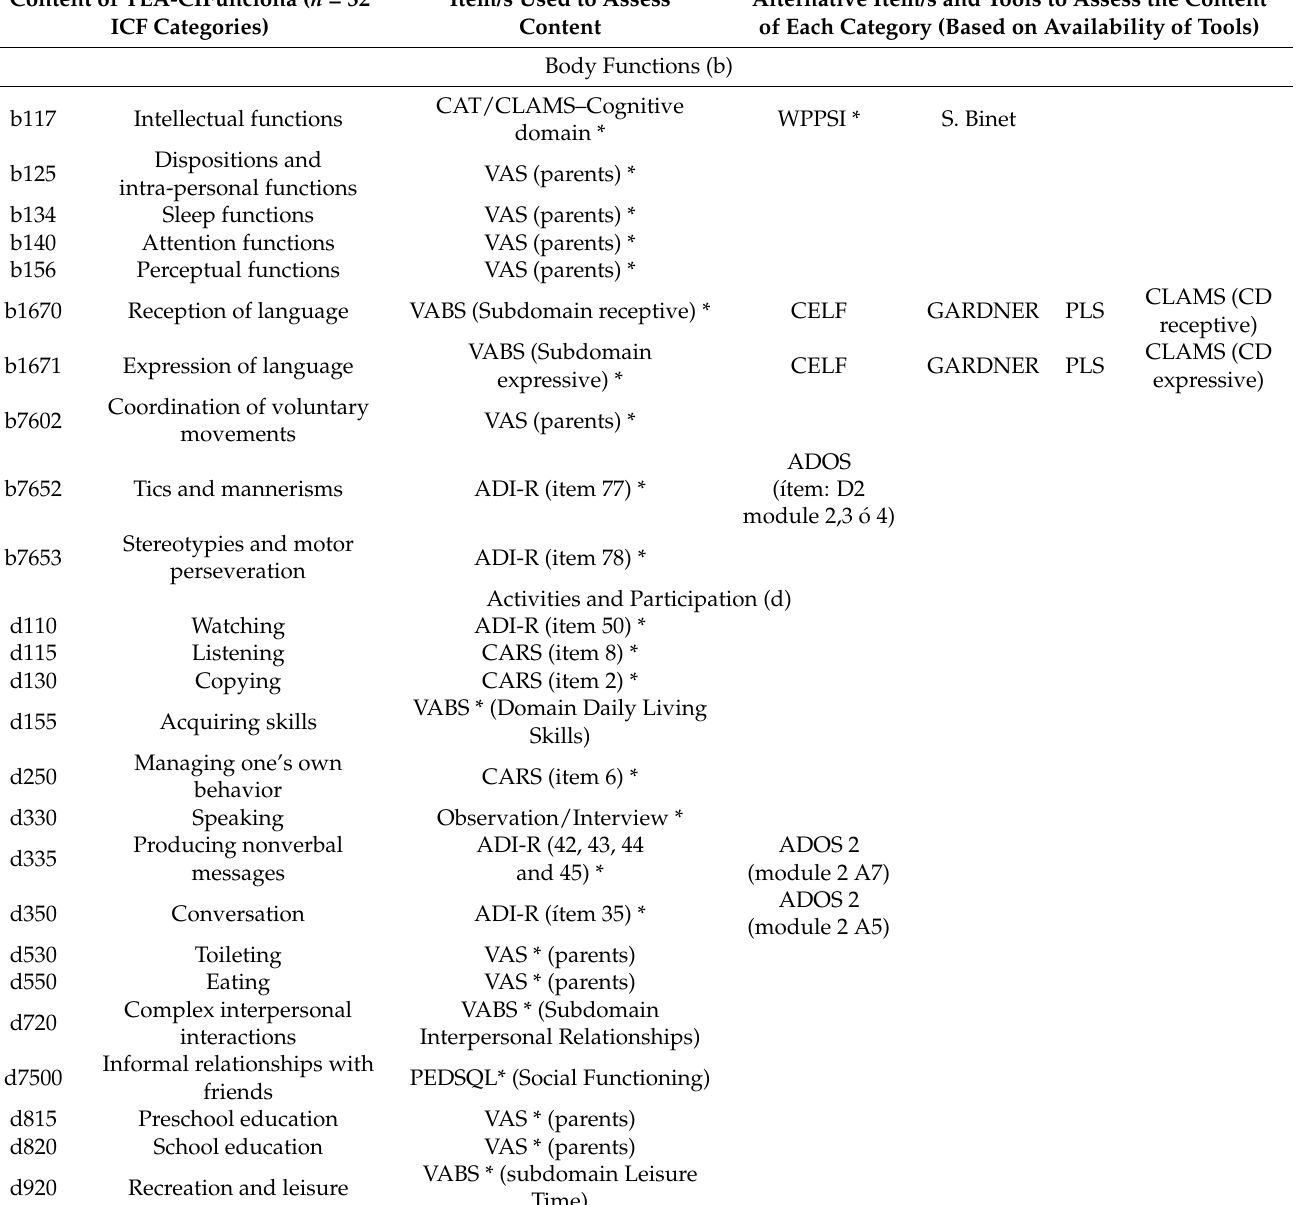
Table 1. TEA-CIFunciona version 1.0 and proposed